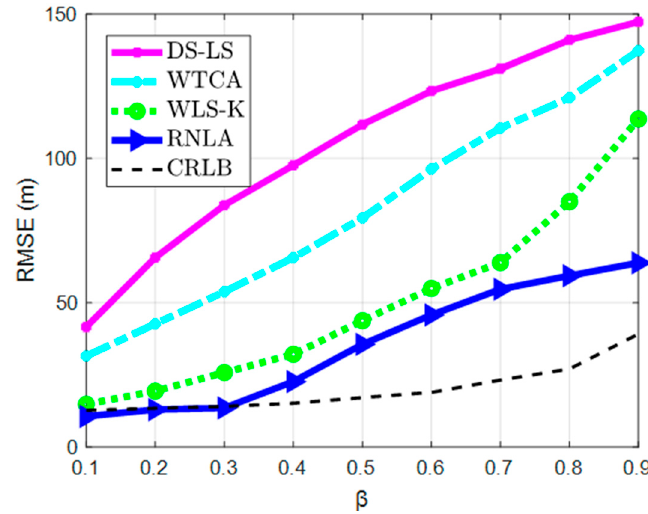
β β . Figure 4. RMSE under variable